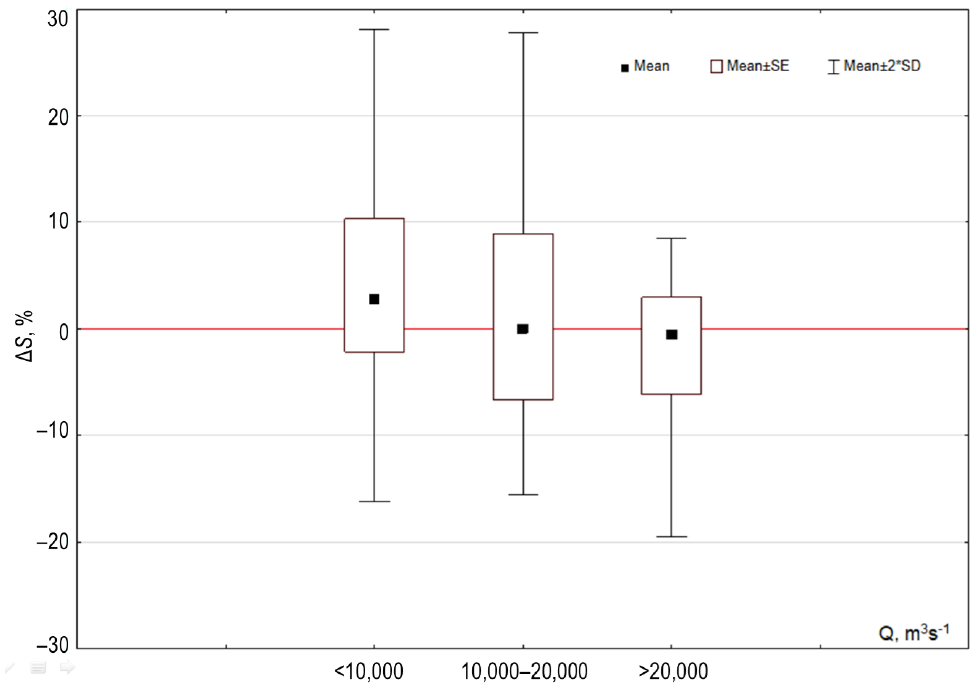
Figure 8. The surface SSC changes ΔS along case study 1 of the Lena River (62 situations in the period from 1992 to 2018).